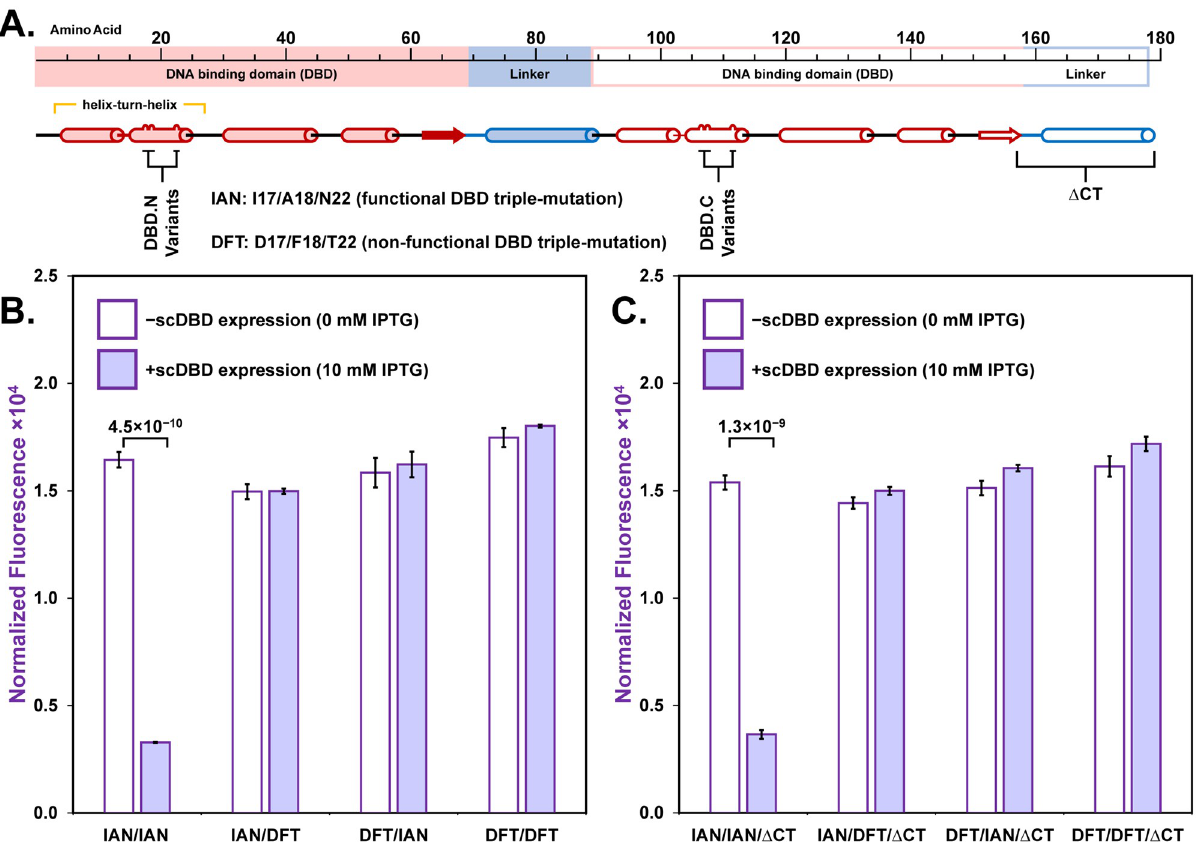
Fig 4. In Vivo evaluation of scDBD repressor function. Four variants of scDBD repressor protein architecture (A) were inserted into the genetic circuit enabling quantification of repressor function, reported by cell density-normalized fluorescence resulting from expression of eGFP. These four variants are comprised of combinatorial pairs of triple-mutations rendering each duplicated DBD functional (IAN: Y17 I /Q18 A /R22 N ) and non- functional (DFT: Y17 D /Q18 F /R22 T ). The repressor function of these four variants was evaluated by measuring genetic circuit output when scDBD production is repressed (0 mM IPTG) and when scDBD is expressed (10 mM IPTG) for full-length (B) and C-terminal truncated (C) constructs. Statistically significant differences ( p -value � 0.001) corresponding to a repression event are indicated (two-tailed homoscedastic t -test, n = 4).